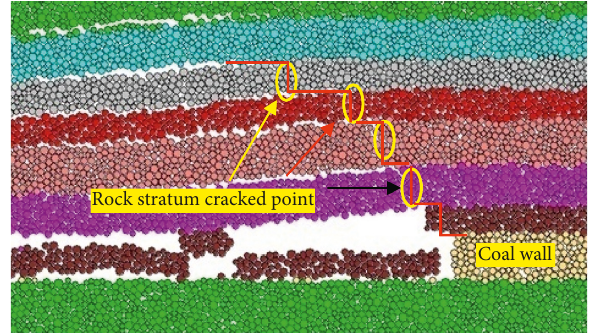
Figure 12: The fracture point of rock stratum.